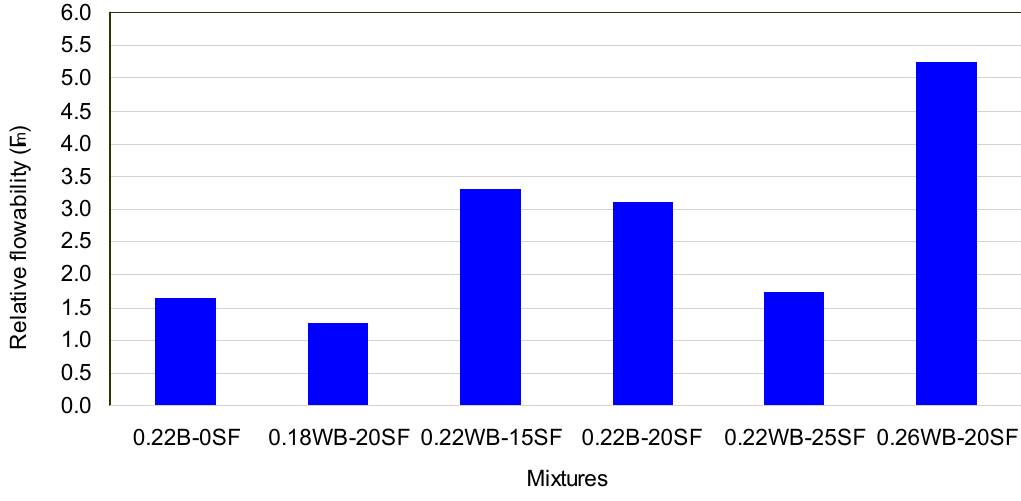
Figure 2. Relative flowability of six key mixtures.